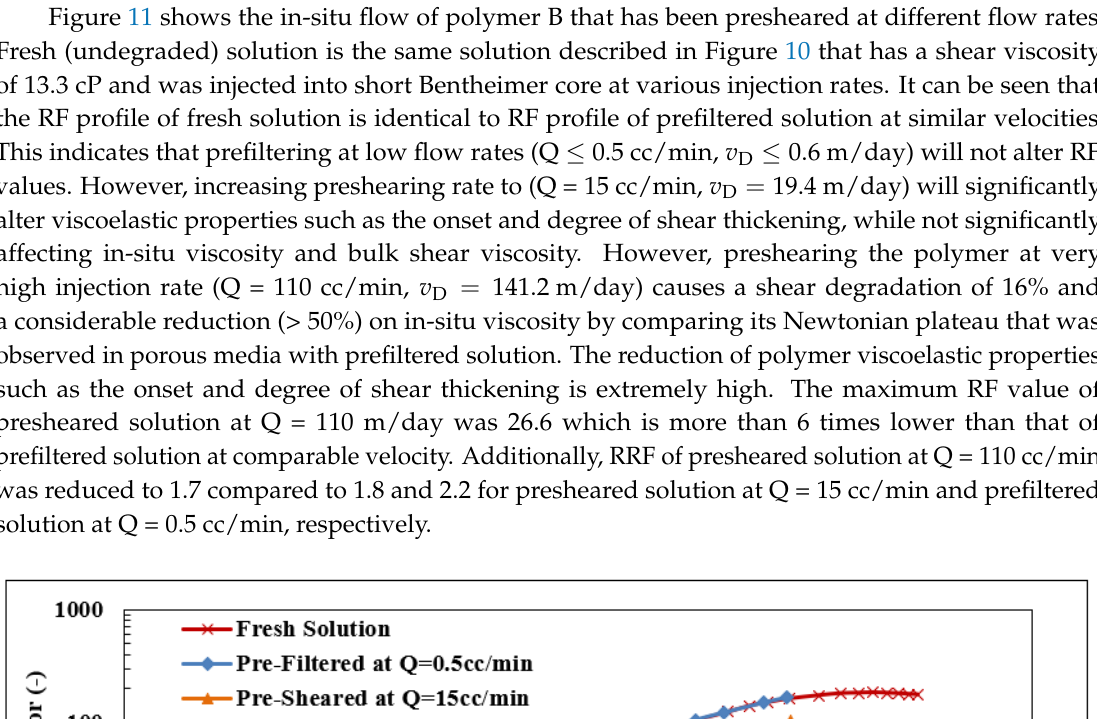
Figure 10. Shear degradation at elevated velocities for polymer A, B and C. Figure 10 Shear degradation at elevated velocities for polymer A, B and C. Figure 10 Shear degradation at elevated velocities for polymer A, B and C.